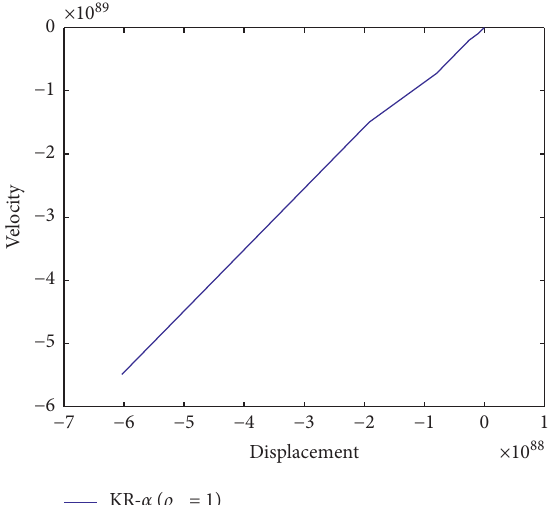
Figure 27: Phase portrait of the hardening spring calculated using the KR- α method ( ρ